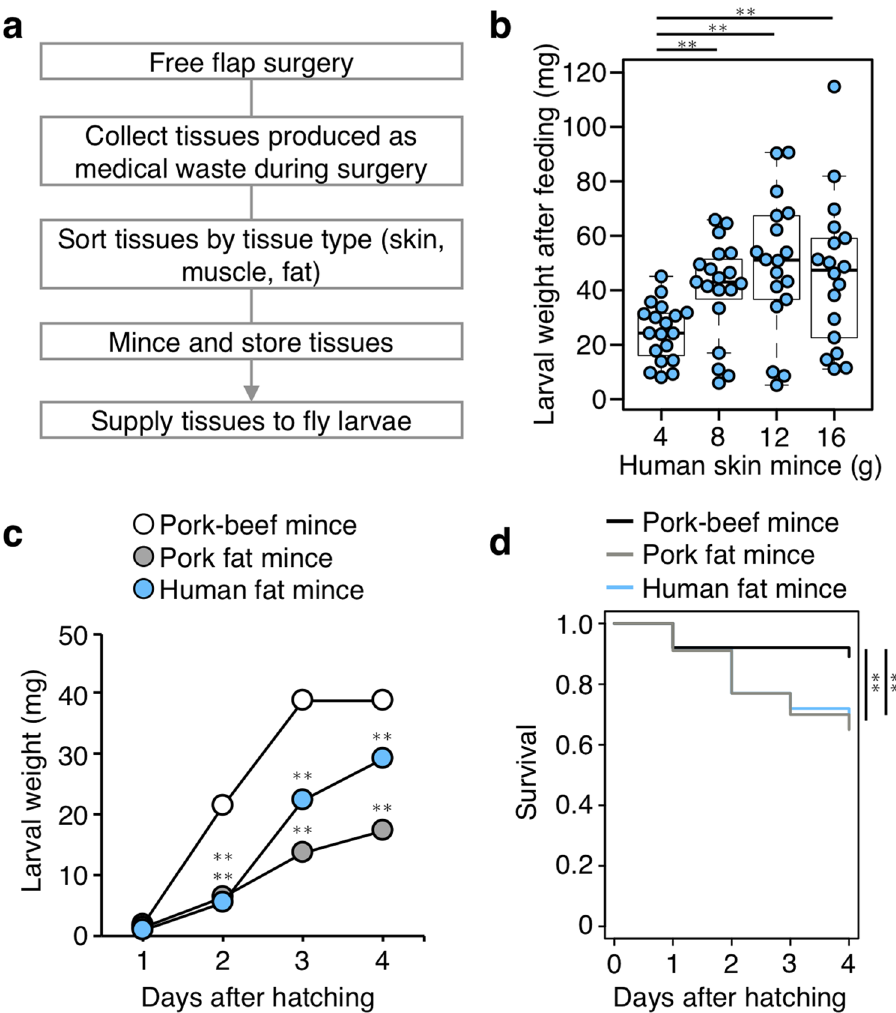
Figure 1. Development of a human tissue-based feeding assay for L. sericata larvae. ( a ) A flowchart describing human tissue preparation for making the diet of fly larvae. During free flap surgery, human tissues produced as medical waste were collected, sorted by type of tissue, minced, and supplied to L. sericata larvae. ( b ) Weight of larvae at 4 days after hatching and fed with human skin mince diet. The indicated amounts of diet were supplied to each group (n = 20). Each dot represents the weight of an individual larva. Boxplots: center line, median; box range, 25th–75th percentiles; whiskers denote minimum–maximum values. Student’s t -test, ** p < 0.01. ( c , d ) Weight and survival ratio of larvae fed on 40 g of pork-beef mince, pork fat mince, or human fat mince. n = 100 per group. The mean values are shown ± SEM in ( c ). Student’s t -test ( c ), two-sided log-rank test ( d ). ** p < 0.01. See also Supplementary Data 1 for data of experiment, exact sample sizes, and p